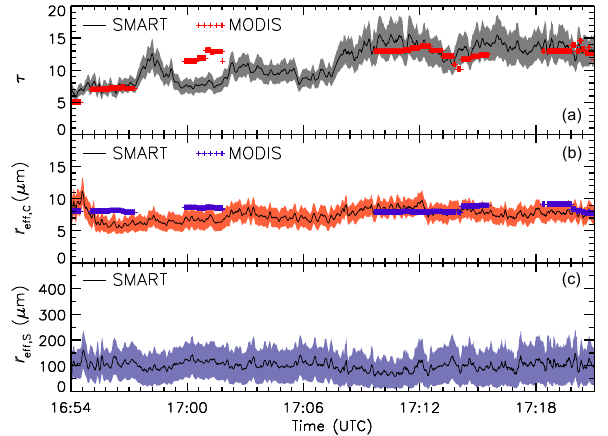
Figure 6. Time series of cloud optical thickness τ (a) , cloud droplet effective radius r eff , C (b) and effective snow grain size r eff , S (c) retrieved from SMART measurements for Case I on 29 April 2012. Uncertainties of the retrieved properties are indicated by dark shaded areas. When available, results of the MODIS cloud product are given for τ and r eff , C (5 × 5 pixel average).